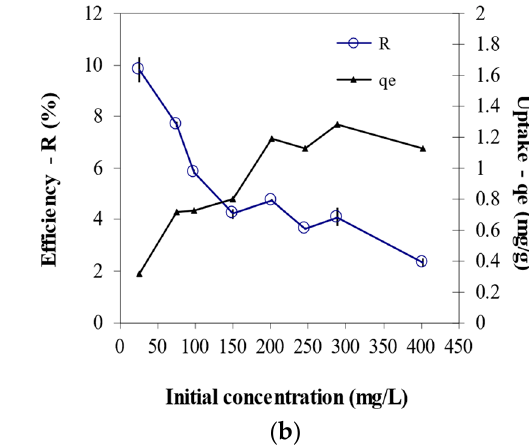
Figure 5. Effect of initial metal concentration on biosorption efficiency and metal uptake capacity of ( a ) Cr 6+ and ( b ) total chromium by Rhodotorula sp. inactive biomass (pH = 1, contact time = 48 ore, biosorbent dosage = 8 g/L, temperature = 25 °C).